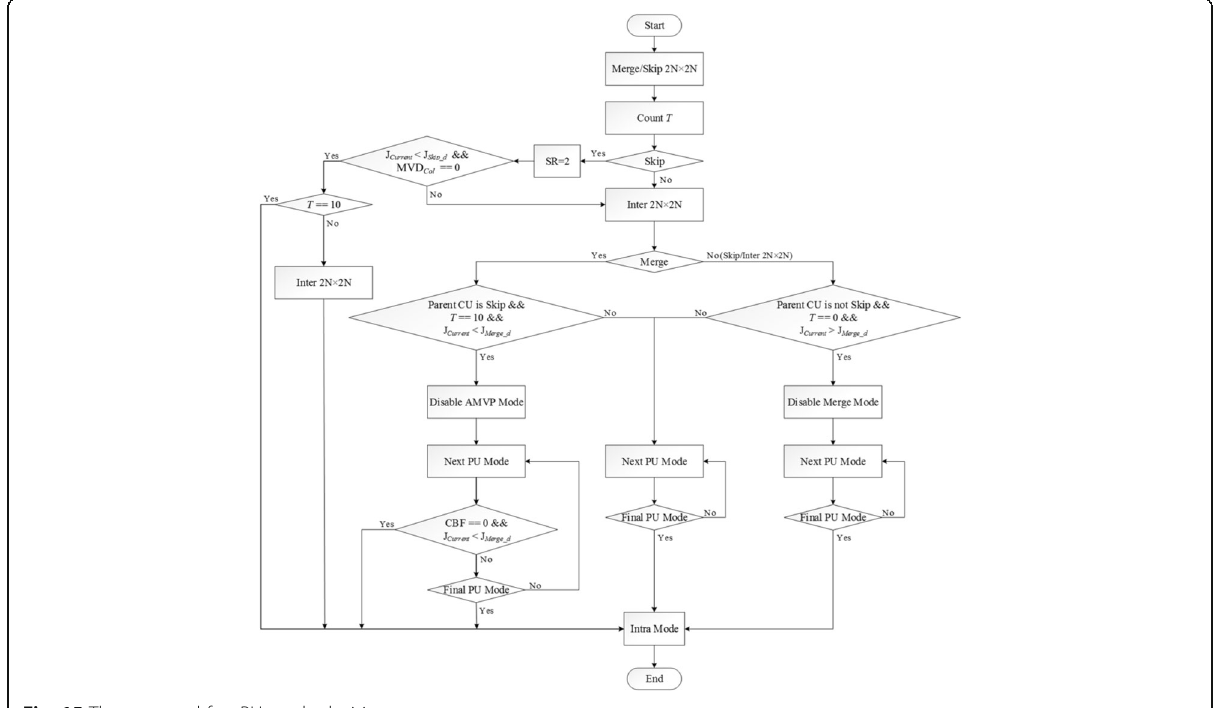
Fig. 15 The proposed fast PU mode decision